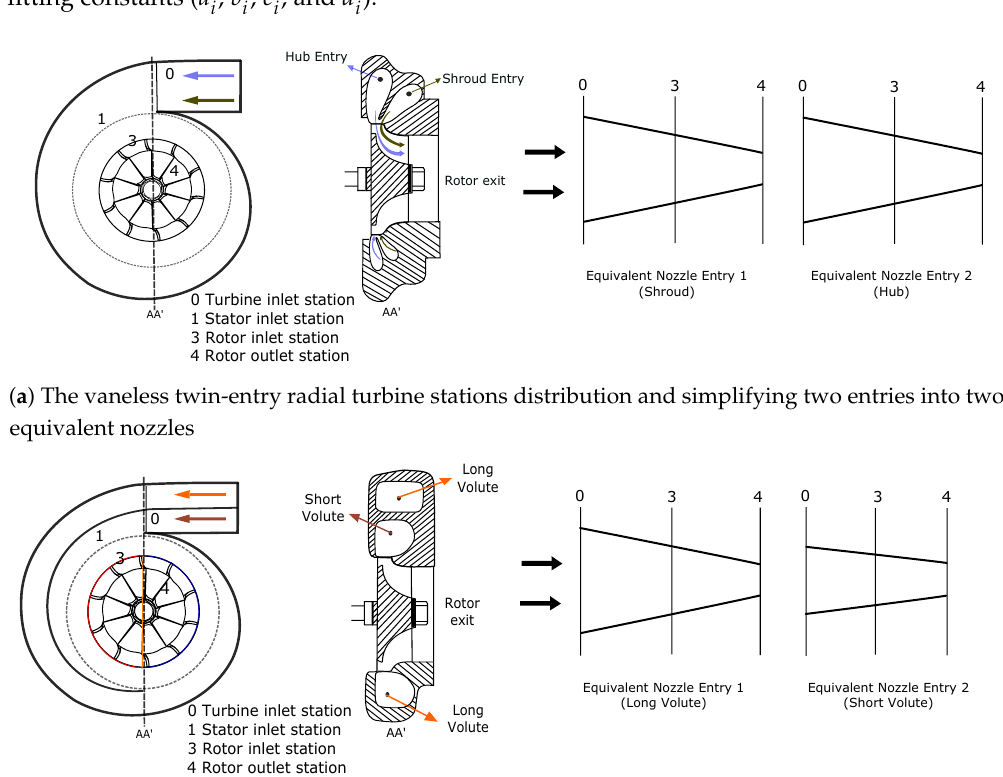
Figure 7. Vaneless double entry turbines station distribution and modeling